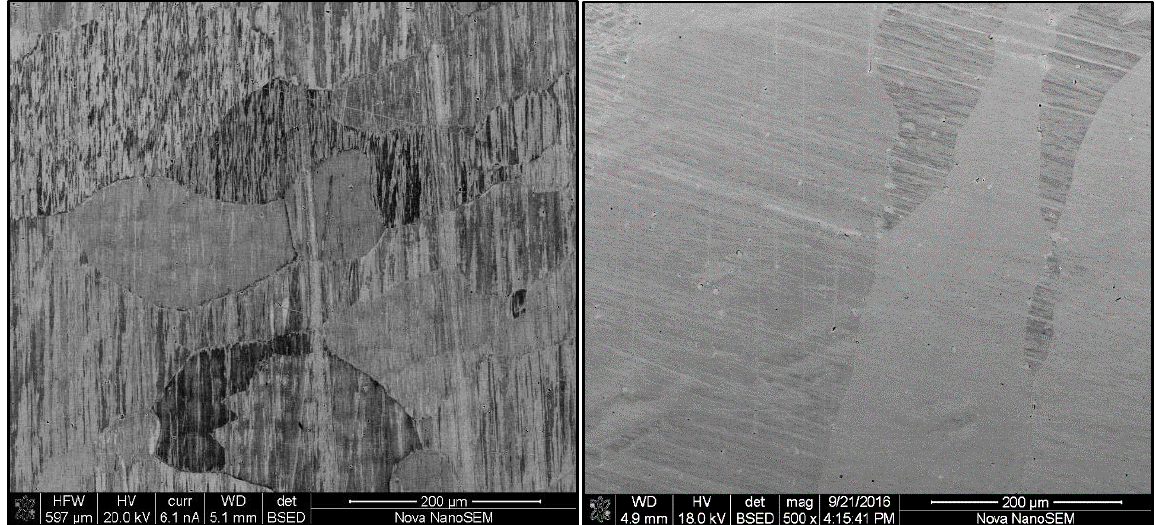
Figure 2. SEM images of the A1 ( left ) and A2 ( right ) alloys. Table 1. Chemical composition (in at%) of A1 and A2 alloys.